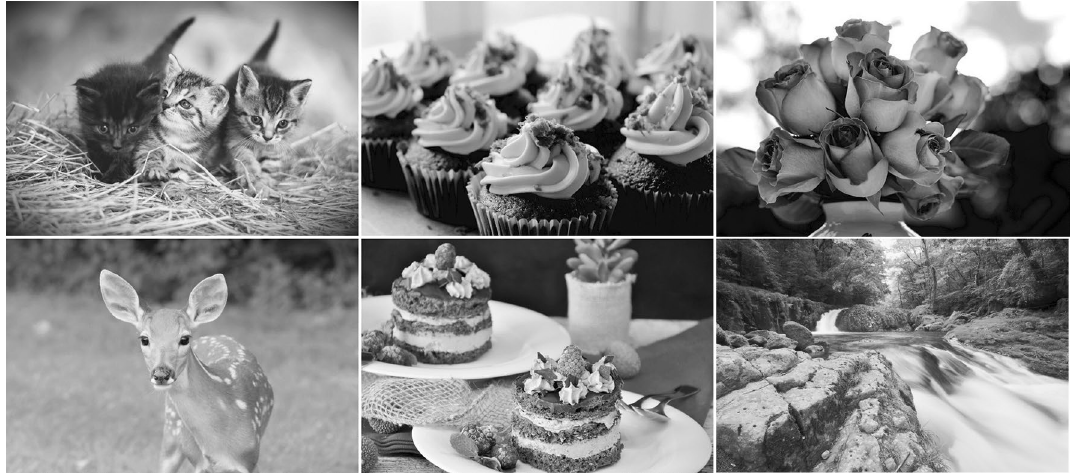
Figure 1. Examples of images presented in the experiment. Top left: ©congerdesign (Creative Commons); top middle: ©Free-Photos (Creative Commons); top right: ©jill111 (Creative Commons); bottom left: ©diane616 (Creative Commons); bottom middle: ©RitaE (Creative Commons); bottom right: ©Junkichi Egashira (Licenced under CC BY